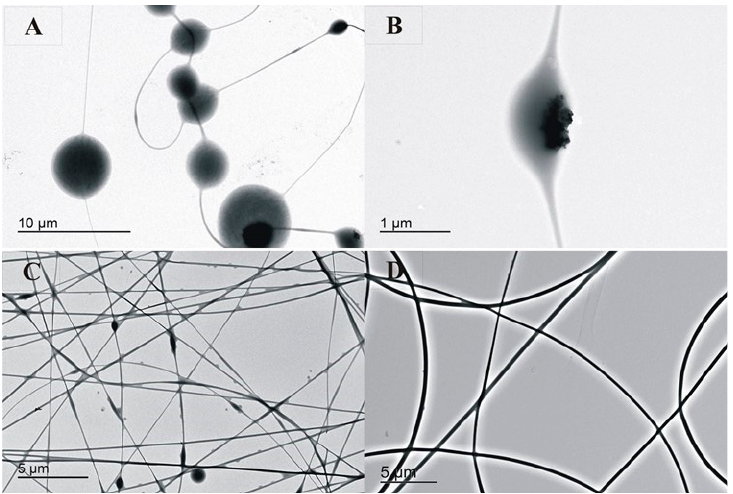
Figure 1. ( A ) (PVOH/GG/AZO-Np) (5/2/0.25) ( w / w ) %, neutral pH, 800×. ( B ) (PVOH/GG/AZO-Np) (5/2/0.25) ( w / w ) %, neutral pH, 5 kX. ( C ) PVOH/GG/AZO-Np) (5/2/0.25) ( w / w ) %, alkaline pH, 1 kX. ( D ) (PVOH/GG/AZO-Np) (5/2/0.25) ( w / w ) %, acidic pH, 800×.